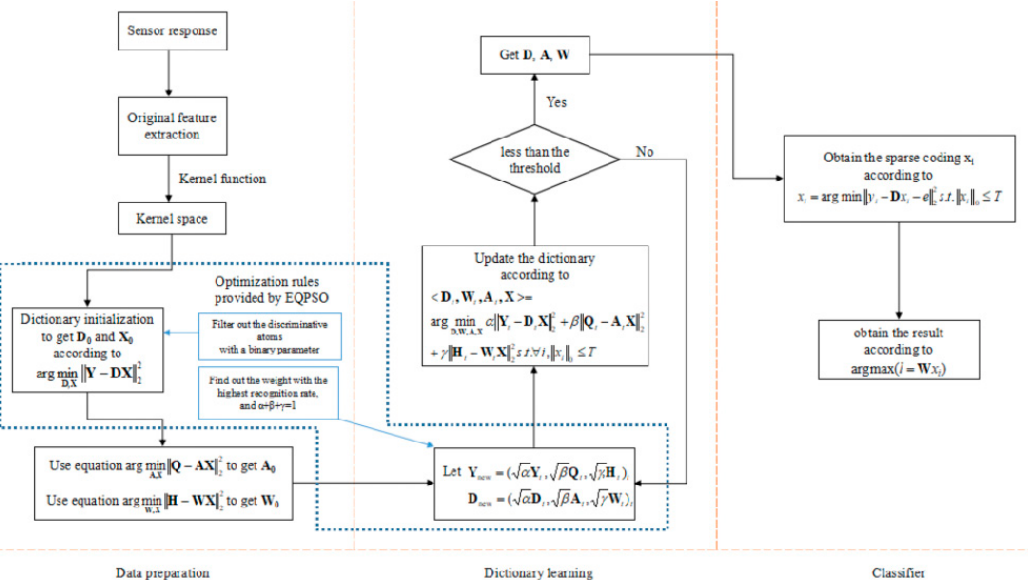
Figure 5. The flow chart of the proposed enhanced label-consistent KSVD (E-LCKSVD). Table 5. The classification accuracy of different KSVD techniques